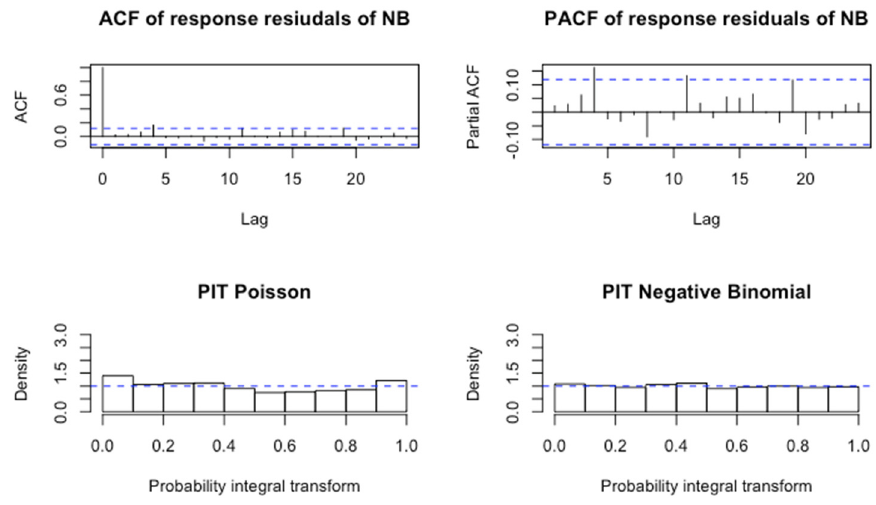
Figure 6. Diagnostic plots after model fitting in Nantung direction. Figure 8. Diagnostic plots after model fitting in Nantung direction.